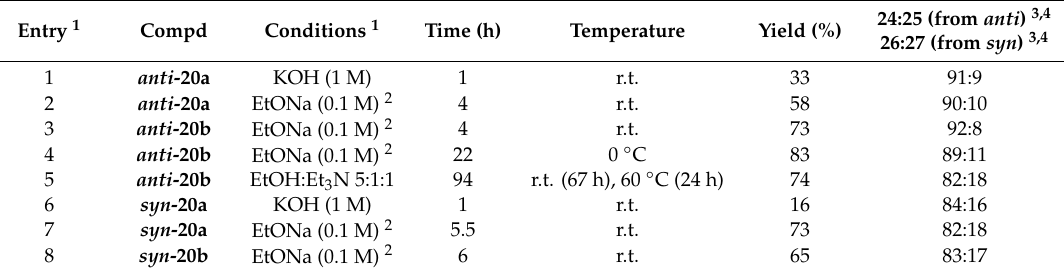
Table 4. Michael cyclization of compounds 20a and 20b